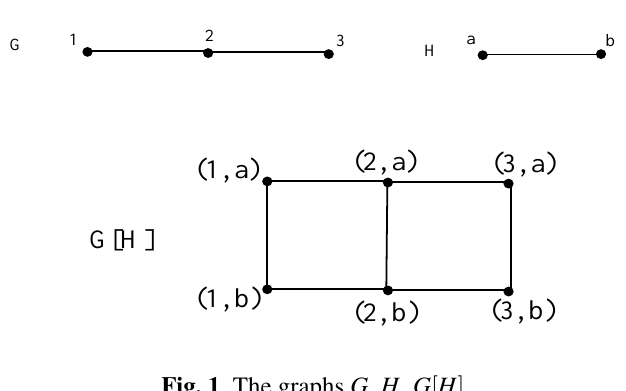
Fig. 1 The graphs G , H , G [ H